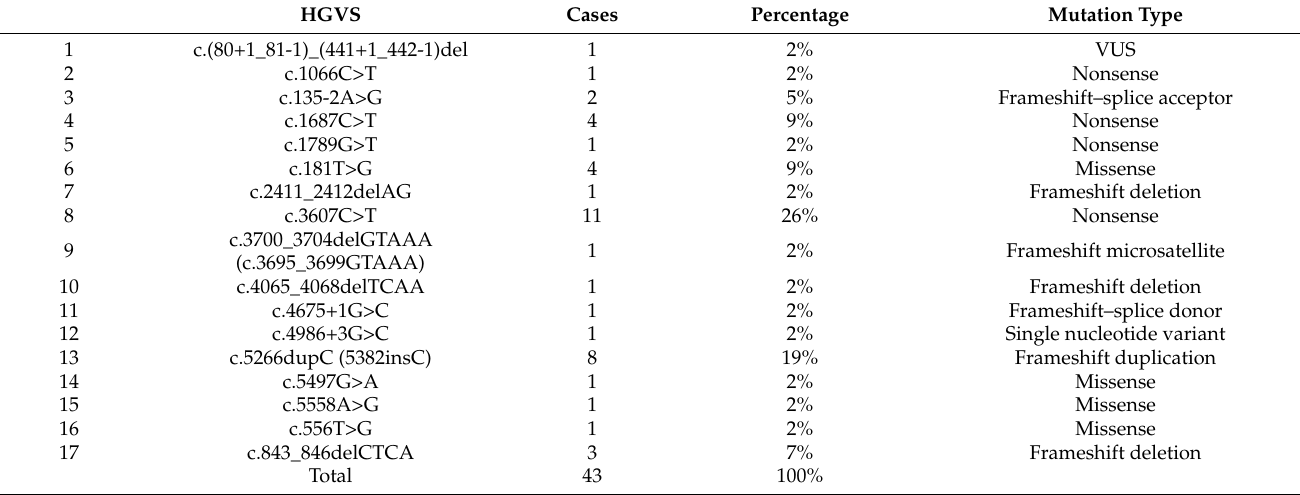
Table 5. BRCA1 mutations (according to the HGVS) and their links to OC in the analyzed group.